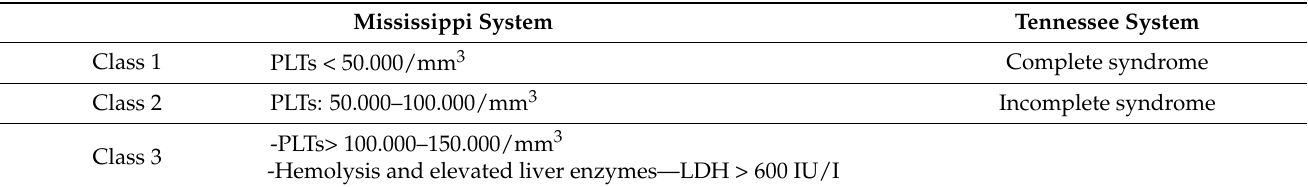
Table 2. Mississippi and Tennessee systems for the classification of HELLP syndrome